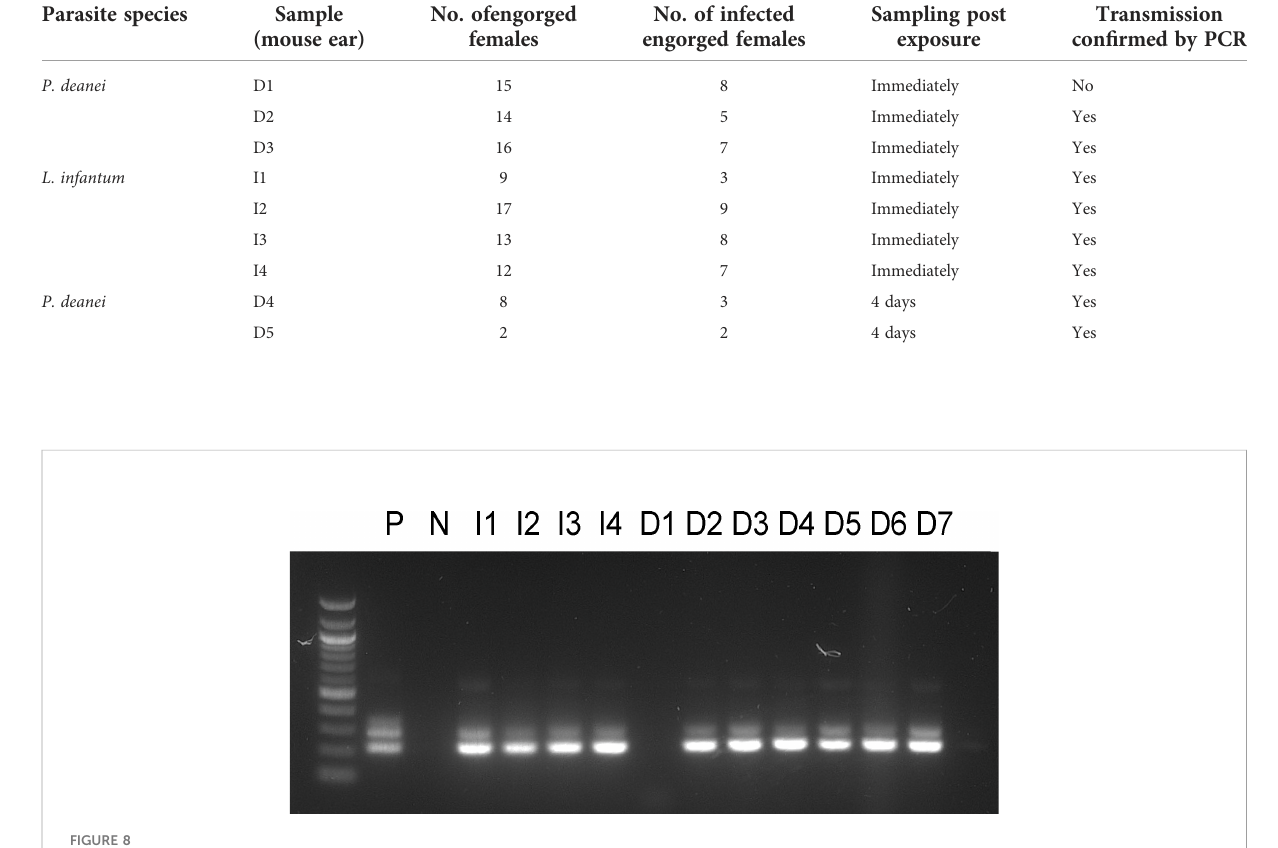
TABLE 3 Microscopical examination of L. longipalpis females allowed to feed on BALB/c mice for transmission of parasites and result of PCR detection of Leishmania minicircle kDNA in mouse ears. Parasite species Sample No. ofengorged No. of infected Sampling post Transmission (mouse ear) females engorged females exposure con fi rmed by PCR